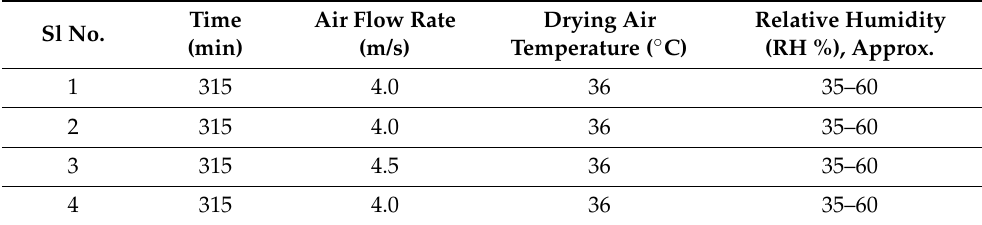
Table 1. Time, air flow rate (m/s), drying air temperature ( ◦ C) and relative humidity (%) during the